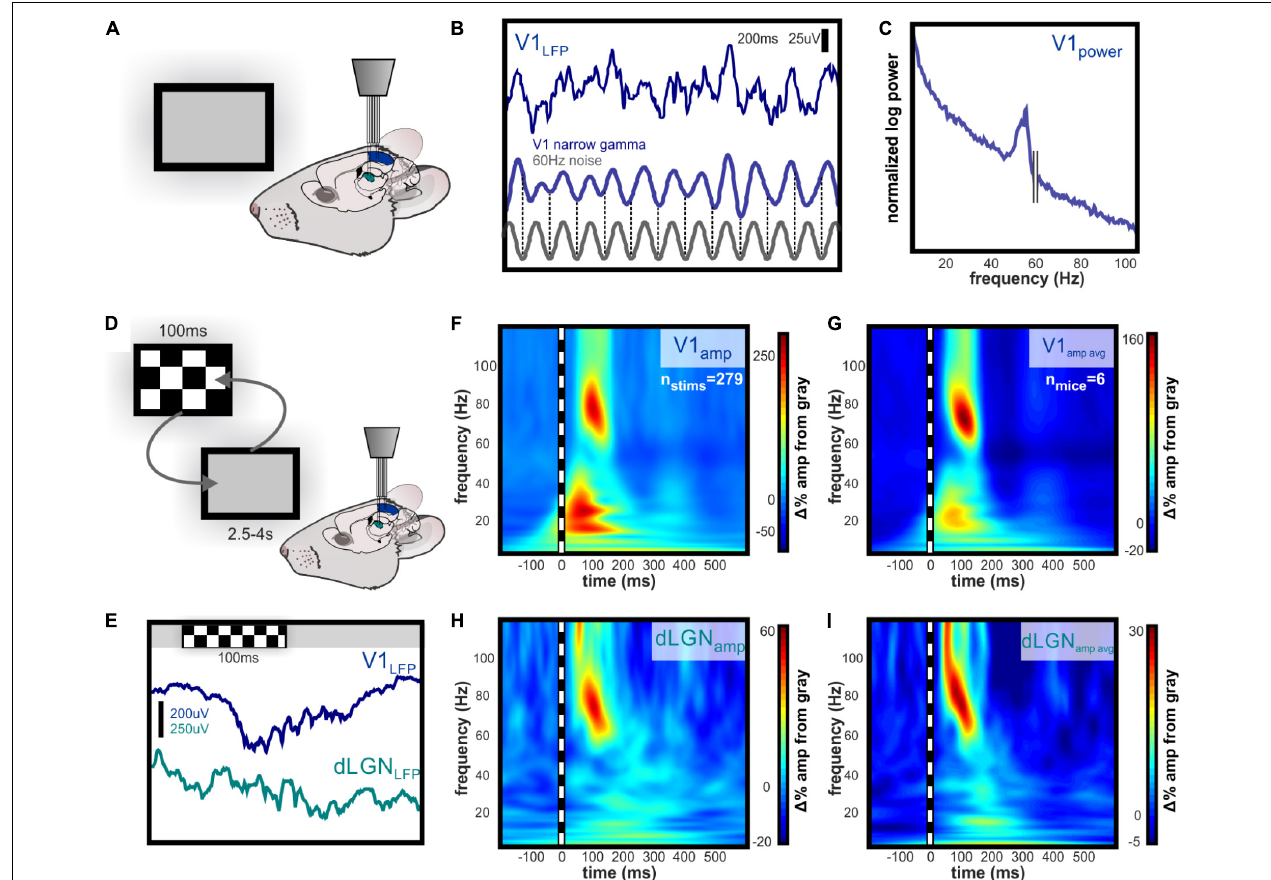
FIGURE 1 | Evoked narrowband and broadband high gamma oscillations dLGN and V1. Independently guided electrodes were used to record LFP and spikes from L4 of V1 and dLGN during visual stimulation. (A) Illustration of experimental setup during baseline recording of activity evoked by viewing of the gray computer screen. (B) Example of 200 ms of raw narrowband gamma in L4 of V1 evoked by luminance of a gray computer screen. The frequency is between 50 and 60 Hz, but ambient 60 Hz electrical noise is not linked to this oscillation, as illustrated by the phase shifts near the beginning and end of trace. (C) Spectral power of narrowband gamma oscillation in V1. Peak in spectral power is apparent below 60 Hz. (D) Illustration of experimental setup during randomized presentation of high contrast checkerboard image. (E) Example raw LFP in V1 and dLGN during single checkerboard presentation. Contrast-evoked oscillations are higher in amplitude and wider in bandwidth than narrowband gamma in V1, and are also visible in dLGN. (F) Example time-frequency analysis of contrast-evoked LFP oscillations in V1, normalized to amplitude during gray screen viewing. 100 ms checkerboard image evokes high amplitude oscillations in distinct low and high gamma frequency ranges. (G) Group mean change in oscillation amplitude over time relative to LFP during gray screen viewing. Peak amplitude change occurs in the 50–90 Hz range 100–125 ms after stimulus onset. (H,I) Same as (F,G) for LFP in dLGN. Low gamma amplitude is not contrast-modulated in dLGN, and high gamma amplitude reaches near-maximal value before